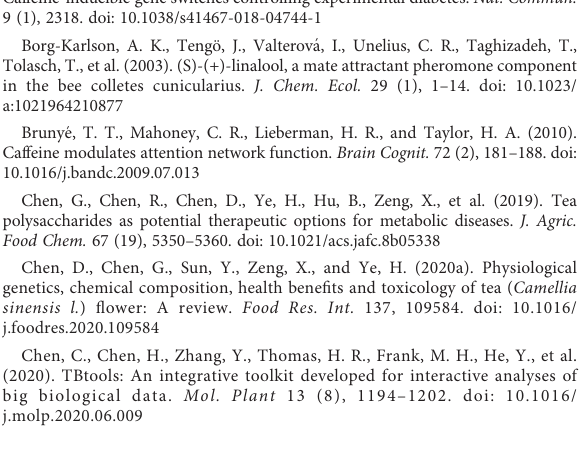
and leaves. SUPPLEMENTARY TABLE 2 Different expression genes in developing fl owers. SUPPLEMENTARY TABLE 3 Expression levels of key genes involved in fl avonoid, caffeine, and terpenoid biosynthesis. SUPPLEMENTARY TABLE 4 Expression levels of TPS gene family in tea fl owers and